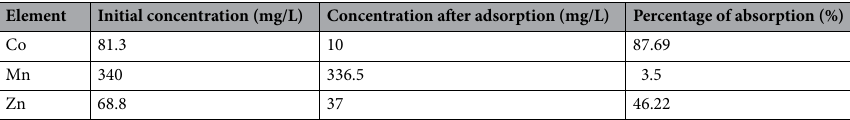
Table 9. Adsorption data with real solution of